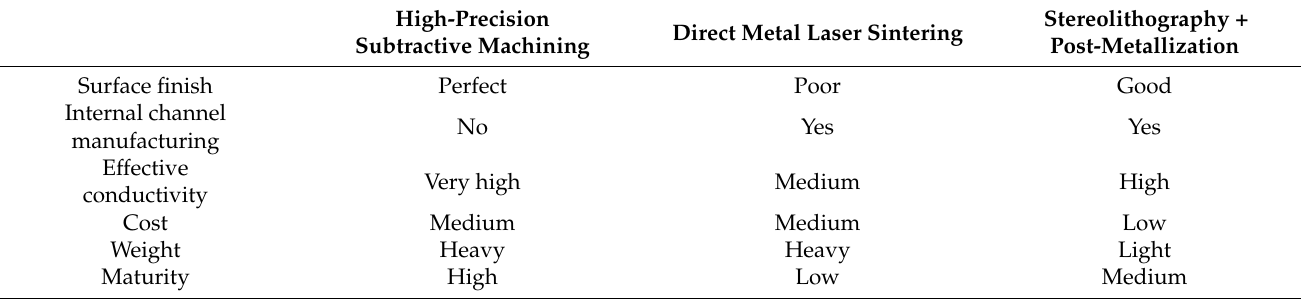
Table 5. Comparison between manufacturing technologies for millimeter-wave antennas. High-Precision Direct Metal Laser Sintering Subtractive Machining